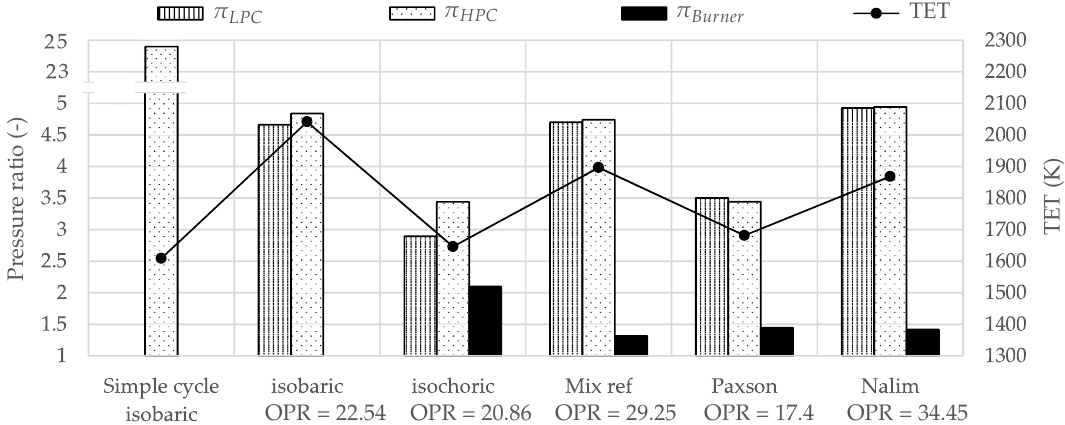
Figure 14. Pressure ratios and TET for the intercooled-recuperated